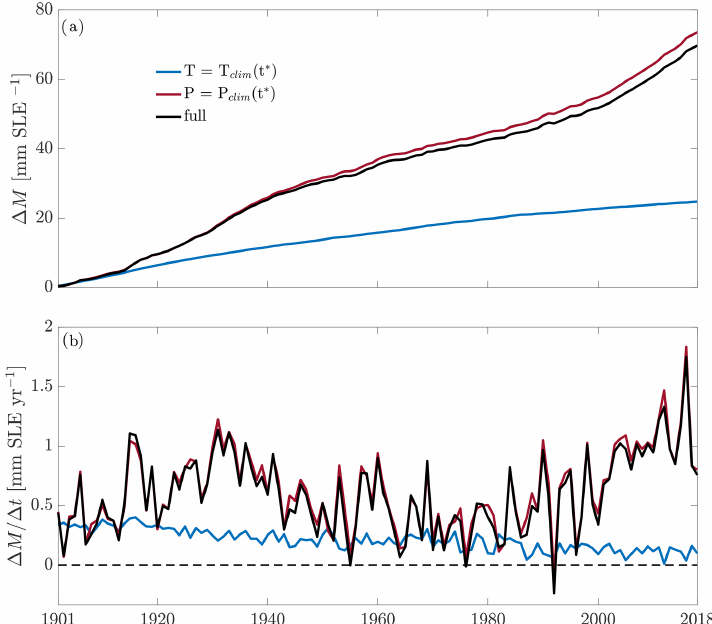
Figure A1. Estimated influence of temperature and precipitation anomalies on global glacier mass change. Red lines are modeled glacier mass change with temperature held constant at the climatology around t ∗ . Blue lines are modeled glacier mass change with total precipitation held constant at the climatology around t ∗ . Black lines represent the model run with full forcing. Note that in the case of this forcing data set we found optimal model performance with t ∗ = 1901, which implies the climatology only includes 16 years. (a) Estimates of GMSLR contribution relative to 1901. (b) Estimated annual GMSLR